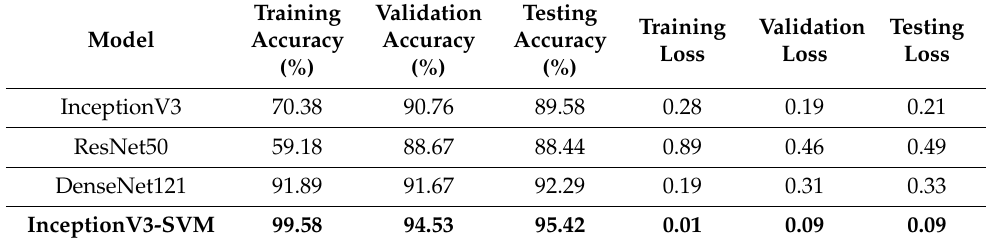
Table 6. Results of the models on the training and validation data